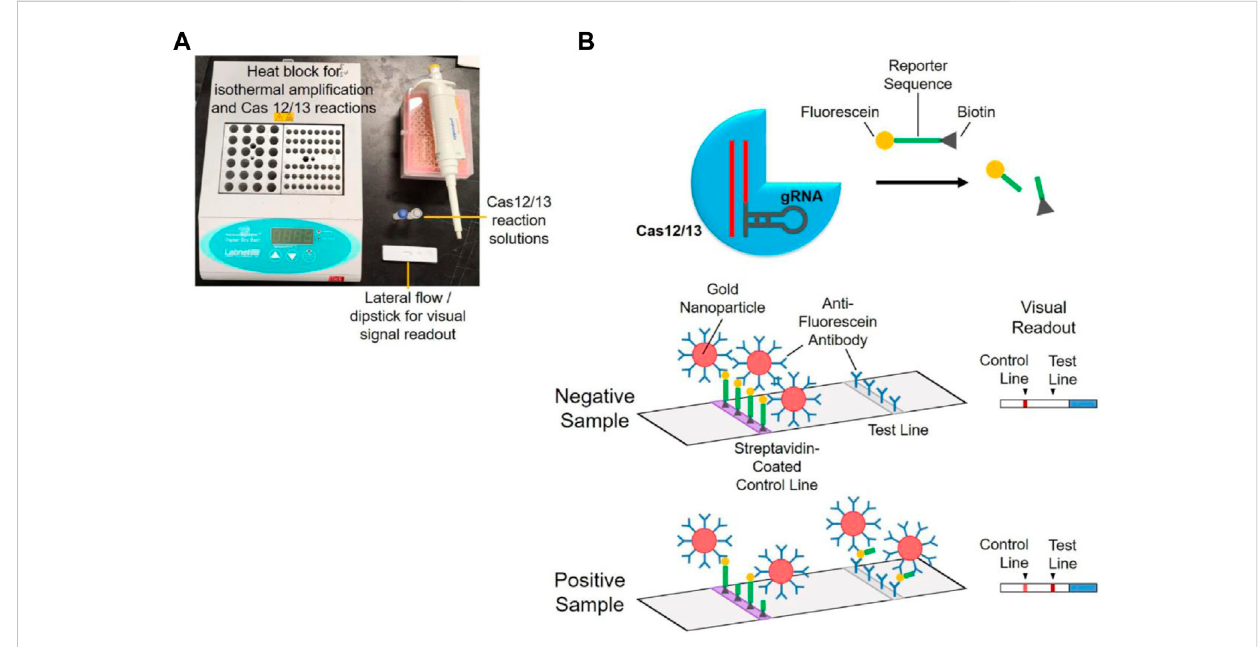
Diagram for the basic steps of using CRISPR-Cas12/13 assay for SARS-CoV-2 detection. (A) Simple instrumentation needed for POC testing. (B) Mechanism for visual signal readout using a lateral fl ow dipstick. Reprinted with permission from Soh et al. (2022). Copyright © 2022 Elsevier Ltd Terms and